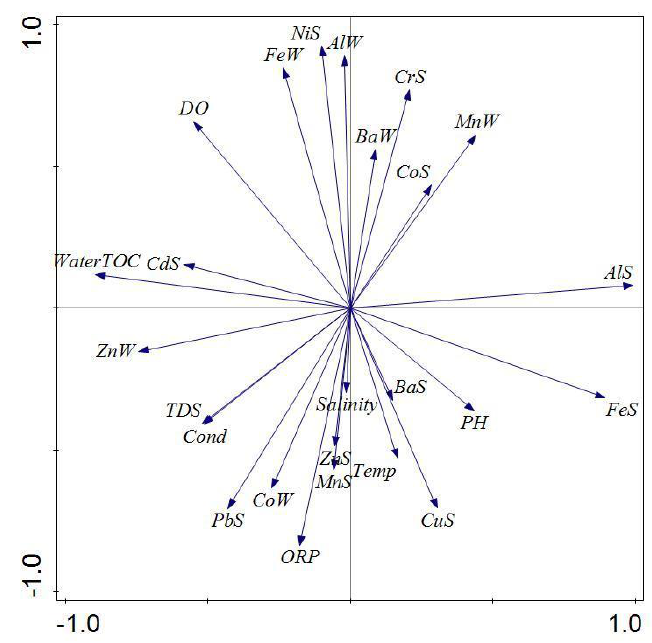
Figure 2. Principal component analysis (PCA) biplot of water and surface sediment parameters in the mangrove forest of Khor al Beida.